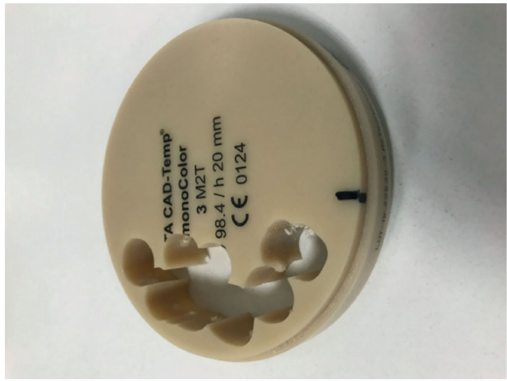
Figure 6. Vita CAD-Temp disk, reprinted with permission from ref. [44] (Copyright 2020 In˙zynier i Fizyk